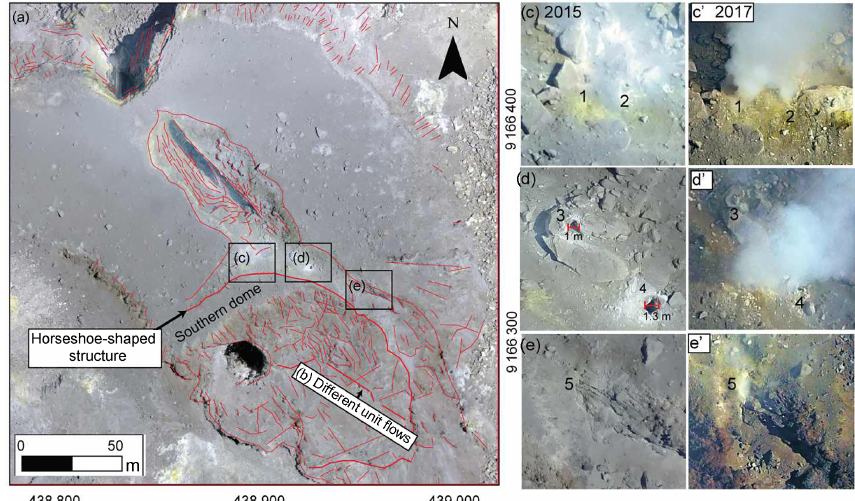
Figure 4. (a) Photomosaic of UAV aerial images acquired in 2015 that shows detailed structures on the Merapi lava dome. The dome is highly fractured at the fissure area, at the dome margin and on the southern dome. (b) A different unit flow and three fracture areas (c, d and e) are clearly identified by our photomosaic drone aerial images. Coordinates are in UTM. Zoomed images of drone images between 2015 and 2017 at those three fractures area show a mechanical weakening due to hydrothermal alteration, especially at the fracture number 5 (area e–e’). We estimate that the diameter of the first, second, third, fourth and fifth fractures is 0.7, 0.3, 1, 1.3 and 0.3m, respectively.